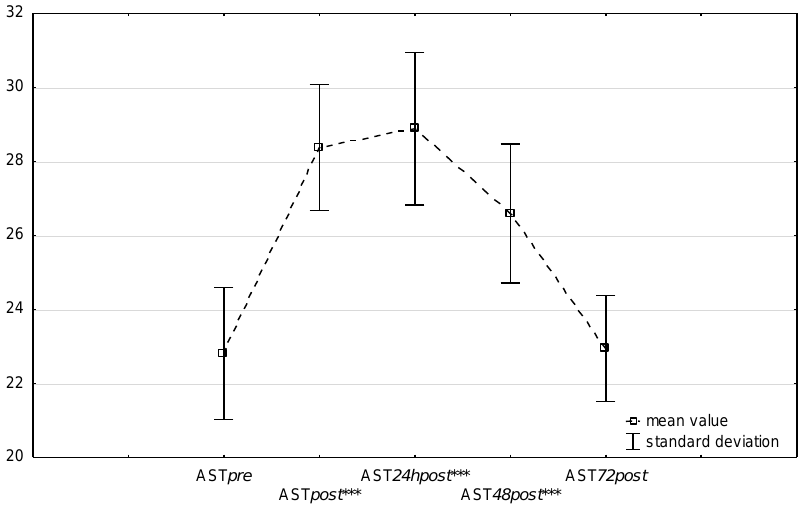
Figure 13. Aspartate transaminase concentrations before and after the match and in the course of post-exercise regeneration with the use of partial body cryostimulation. *** significant differences vs. ASTpre at p < 0.001